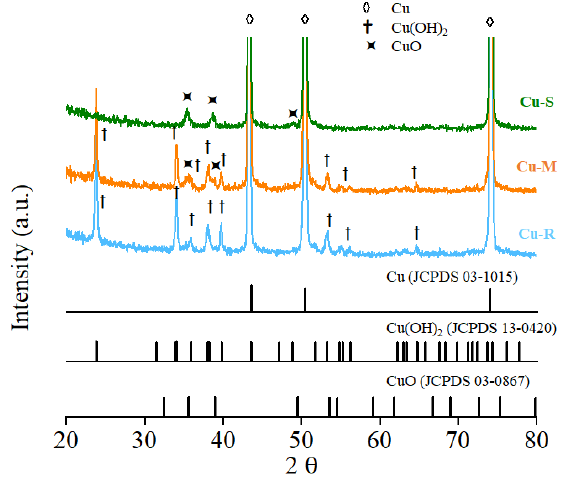
Figure 3. XRD patterns of Cu-R, Cu-M, and